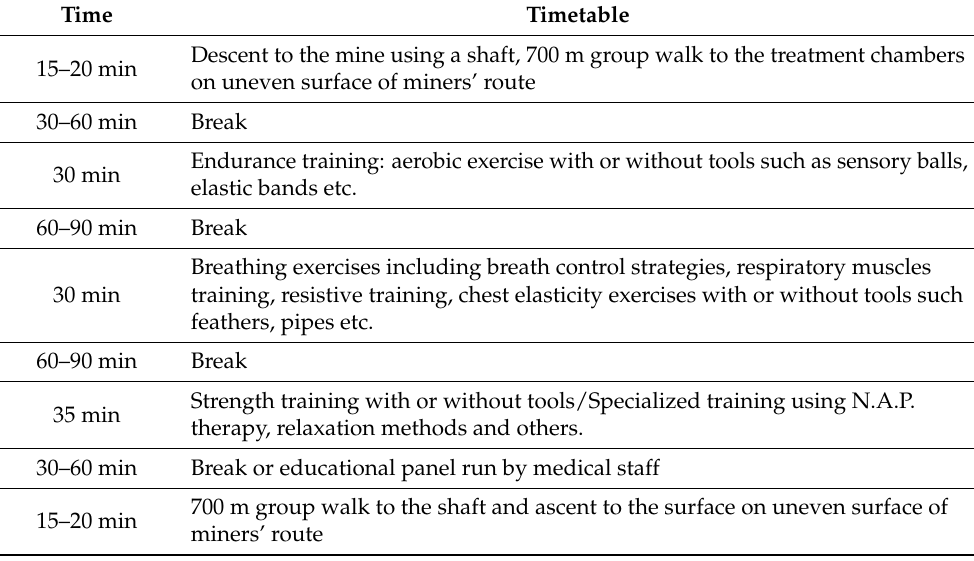
Table 1. Day schedule of the rehabilitation and treatment stay at the “Wieliczka” Salt Mine Health Resort in